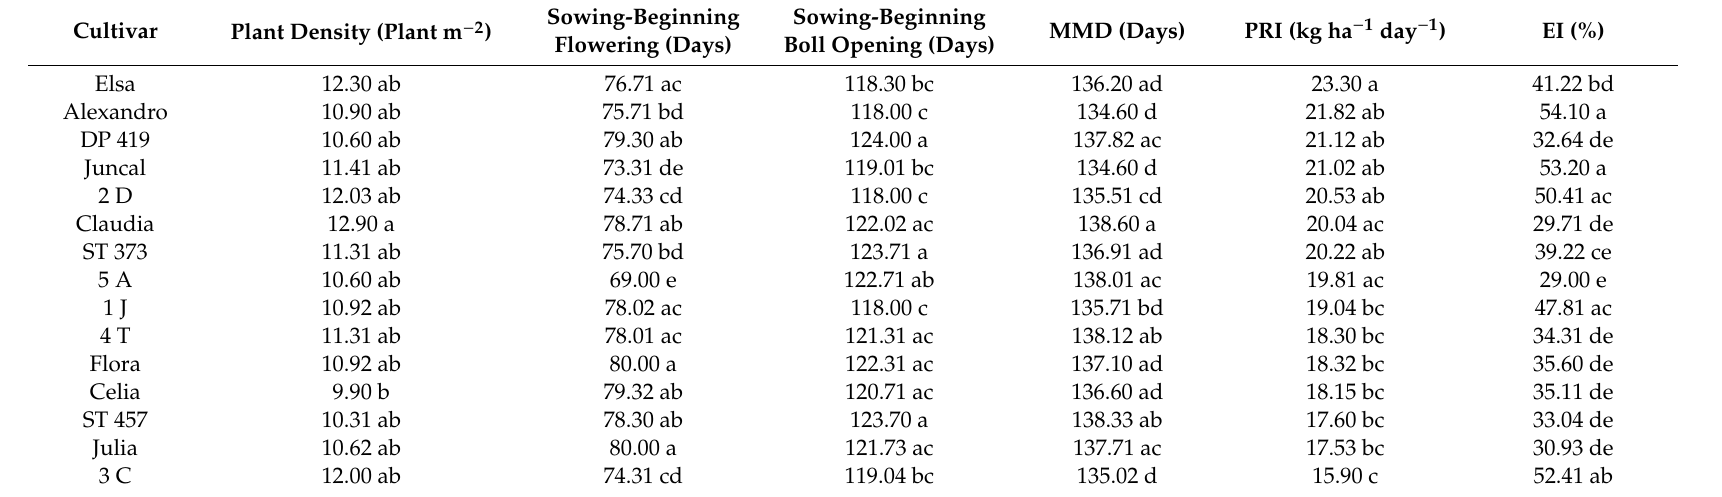
Table 2. Phenological characteristics of 15 cotton cultivars in during the year 2011 and main indices of agronomic earliness used in the study. Cultivar Plant Density (Plant m − 2